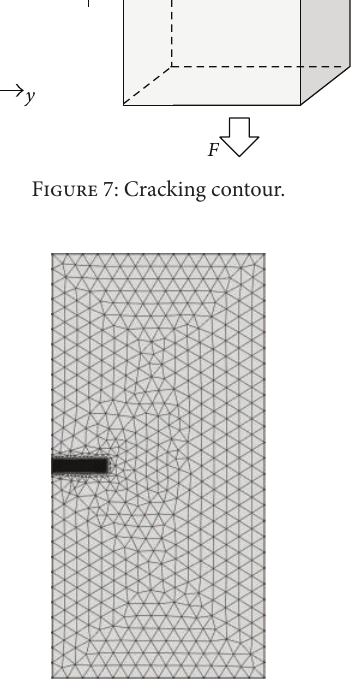
Figure 8: Fixed Eulerian mesh in preflawed bitumen model.